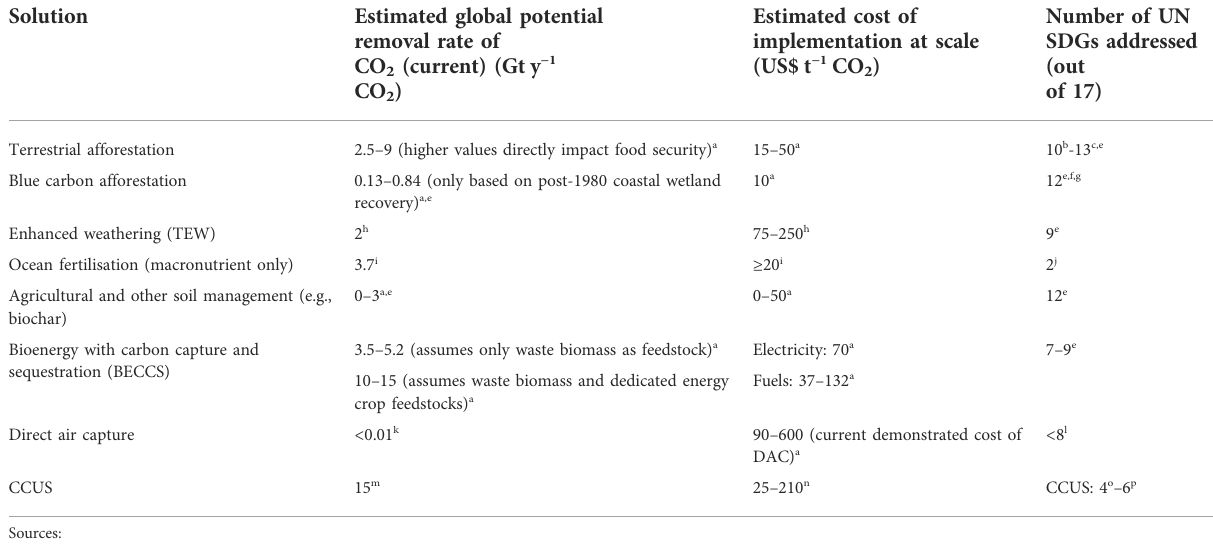
TABLE 3 Summary of CCUS solutions including cost estimates, CO 2 removal rate estimates and UN Sustainable Development Goals (UN SDGs) addressed.